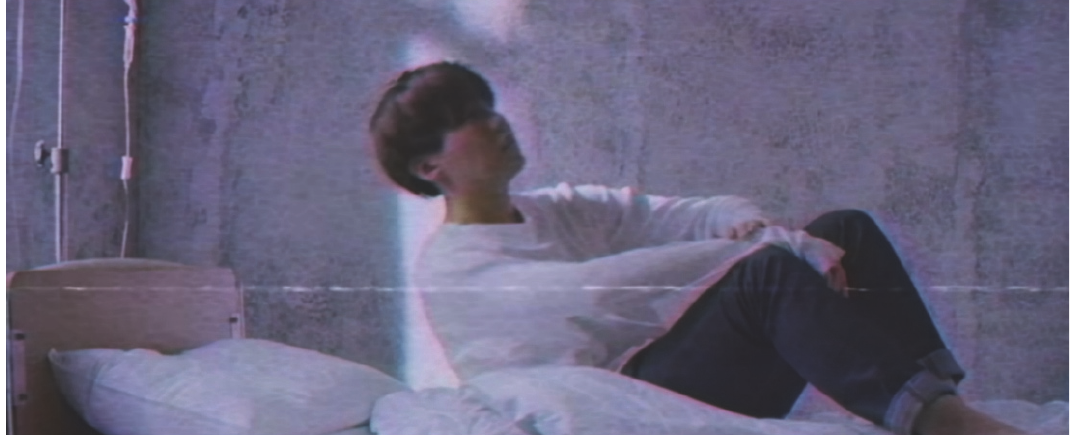
<Figure 4> Image of Hospitalization in BTS. (2016a). “Epilogue: Young Forever” Official